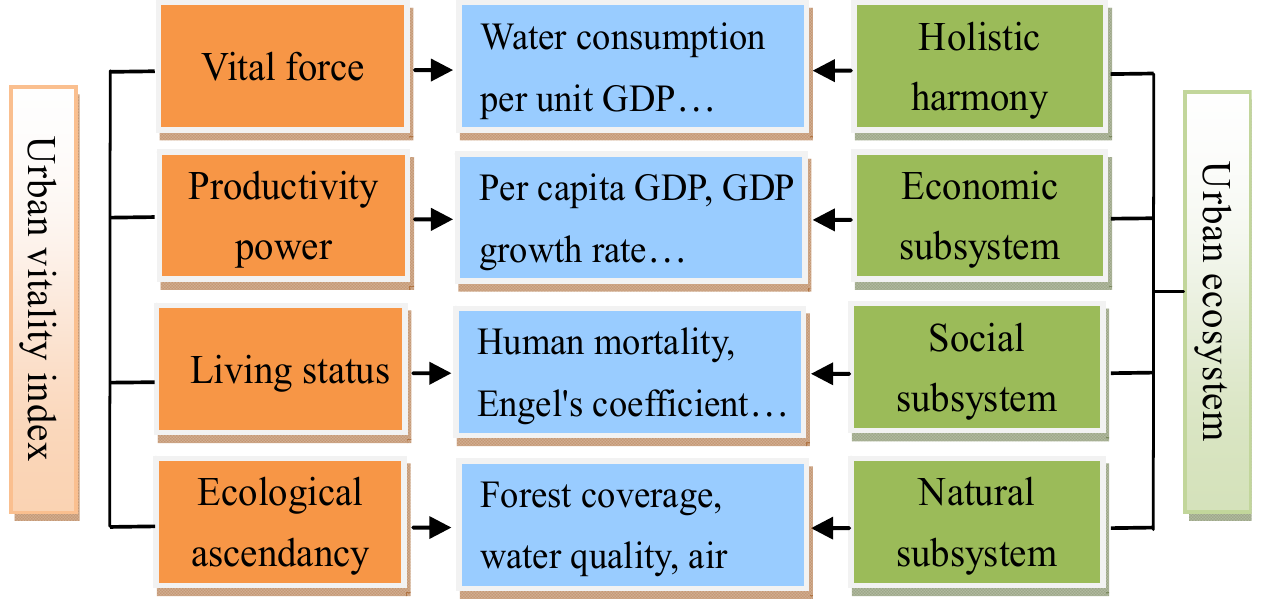
Figure 2. Sketch of the vitality index model of urban ecosystem health assessment.